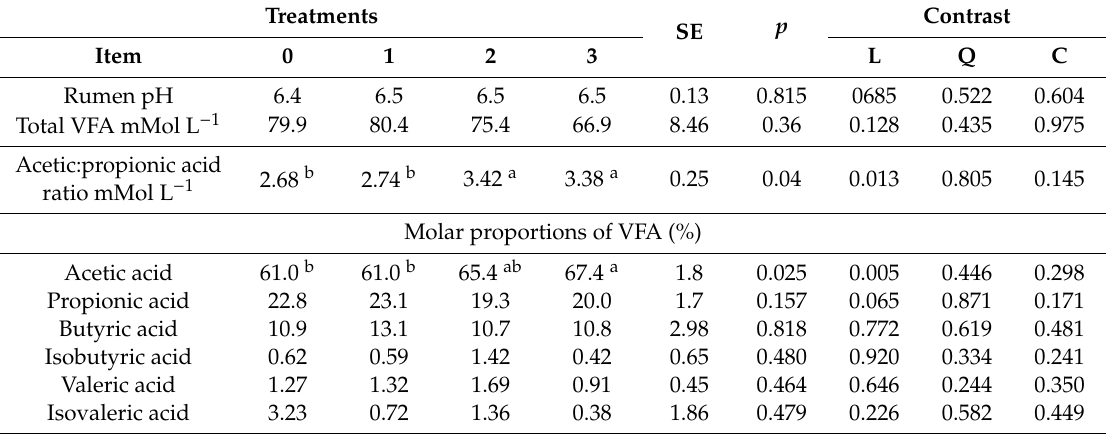
Table 5. E ff ect of dried L. leucocephala leaves supplementation on fermentation in the rumen of heifers.